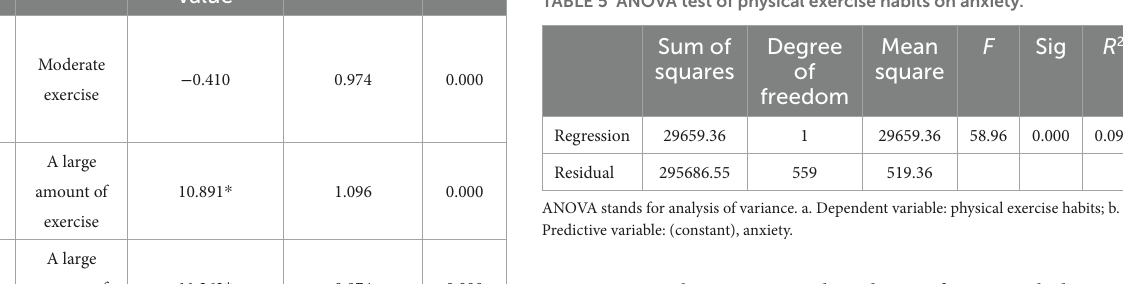
TABLE 5 ANOVA test of physical exercise habits on